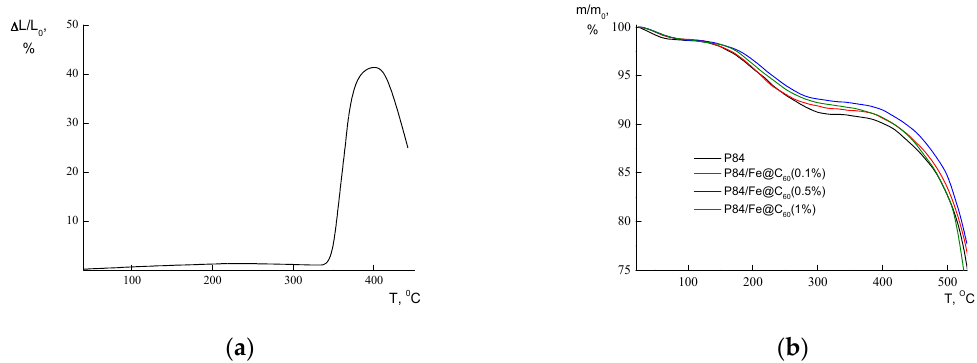
Figure 3. ( a ) Thermomechanical curve: The deformation of the sample ( ∆ L/L ) vs. temperature; ( b ) TGA curves of P84 and P84/Fe@C 60 membranes.